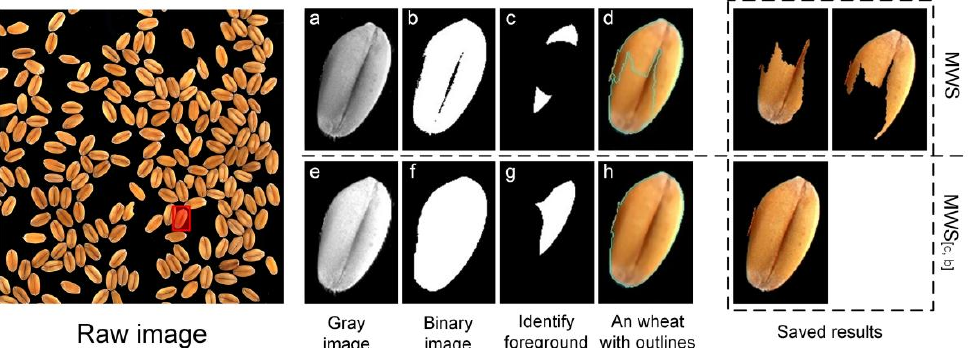
Figure 3. An example of over-segmentation using MWS method, and the exhibition using our improved method. MWS represents the marker-based watershed segmentation algorithm, and MWS [c,b] represents our improved method. ( a – d ) represent a gray image, a binary image, an identify foreground image and a segmented image by MWS, respectively; ( e – h ) represent the corresponding to ( a – d ) by our proposed method.